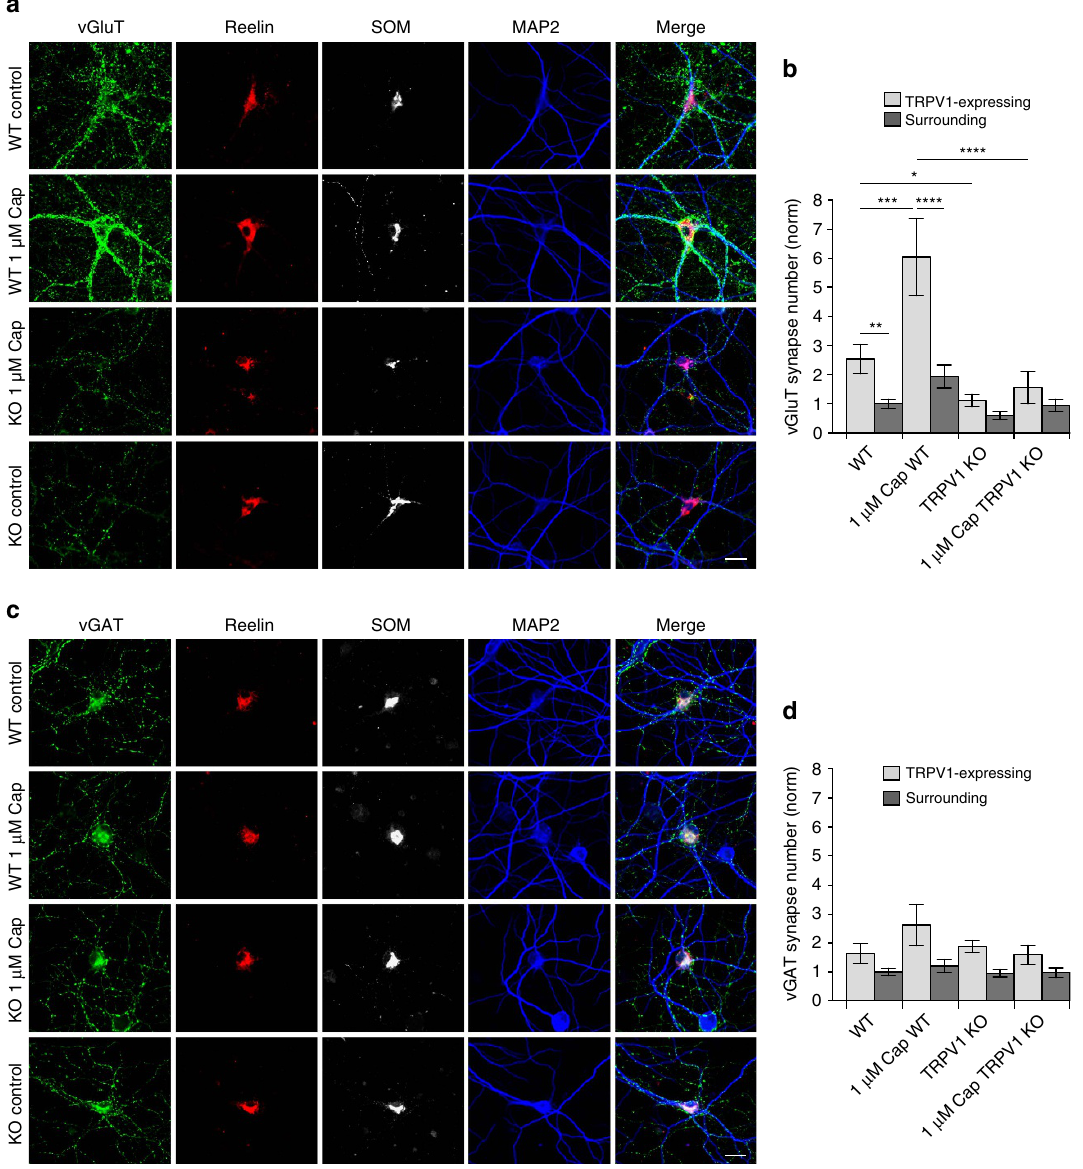
Figure 5 | TRPV1 promotes excitatory innervation of OLM neurons. ( a ) Quadruple immunostains of WT and TRPV1 KO hippocampal neurons with vGluT1 to assay excitatory presynaptic innervation, somatostatin and reelin to identify OLM cells, and MAP2 to identify neuronal somas and dendritic processes, in the indicated conditions. Merge indicates combination of vGluT, reelin and MAP-2 channels; scale bar, 20 m m. ( b ) Quantitation of excitatory synapse (vGluT1 puncta) number, in the indicated conditions, normalized to surrounding non-TRPV1-expressing cells. TRPV1 KO OLM neurons have reduced excitatory innervation, compared to WT ( n ¼ 20 images for all conditions from three cultures). ( c ) Quadruple immunostain of WTand TRPV1 KO hippocampal neurons for vGAT, to mark inhibitory synapses, reelin, somatostatin, and MAP2. Merge indicates combination of vGAT, reelin and MAP2 channels; scale bar, 20 m m. ( d ) Quantitation of inhibitory synapse (vGAT puncta) number, in the indicated conditions, normalized to surrounding non-TRPV1-expressing cells ( n ¼ 20 images for all conditions from 2 cultures). Error ¼ s.e.m., statistical significance determined by one-way ANOVA